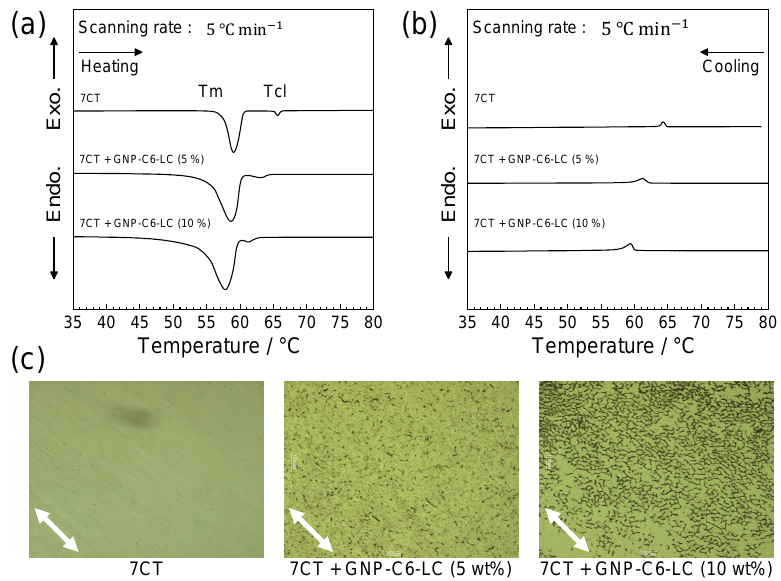
Figure 6. DSC curves on ( a ) heating and ( b ) cooling, and ( c ) open Nicol images in the homogeneous cells (white arrow: rubbing direction) of 7CT and the composites consisting of 7CT and GNP-C6-LC (5, 10